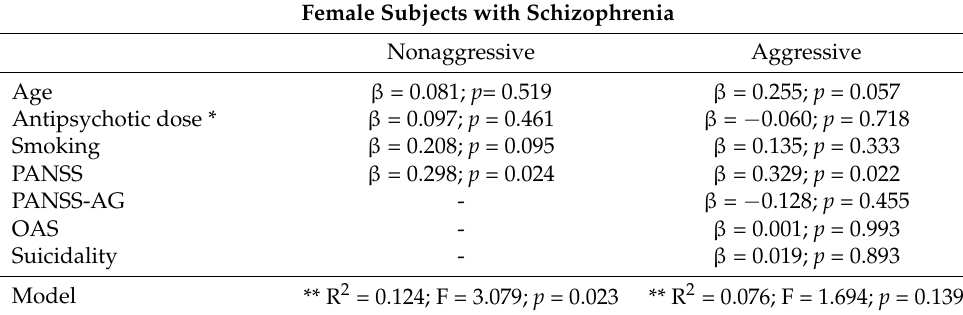
Table 3. HDL cholesterol concentration depending on age, smoking, dose of antipsychotics, severity of symptoms of schizophrenia (PANSS), aggression (PANSS-AG, OAS), and suicidal behavior in nonaggressive and aggressive subjects with schizophrenia.